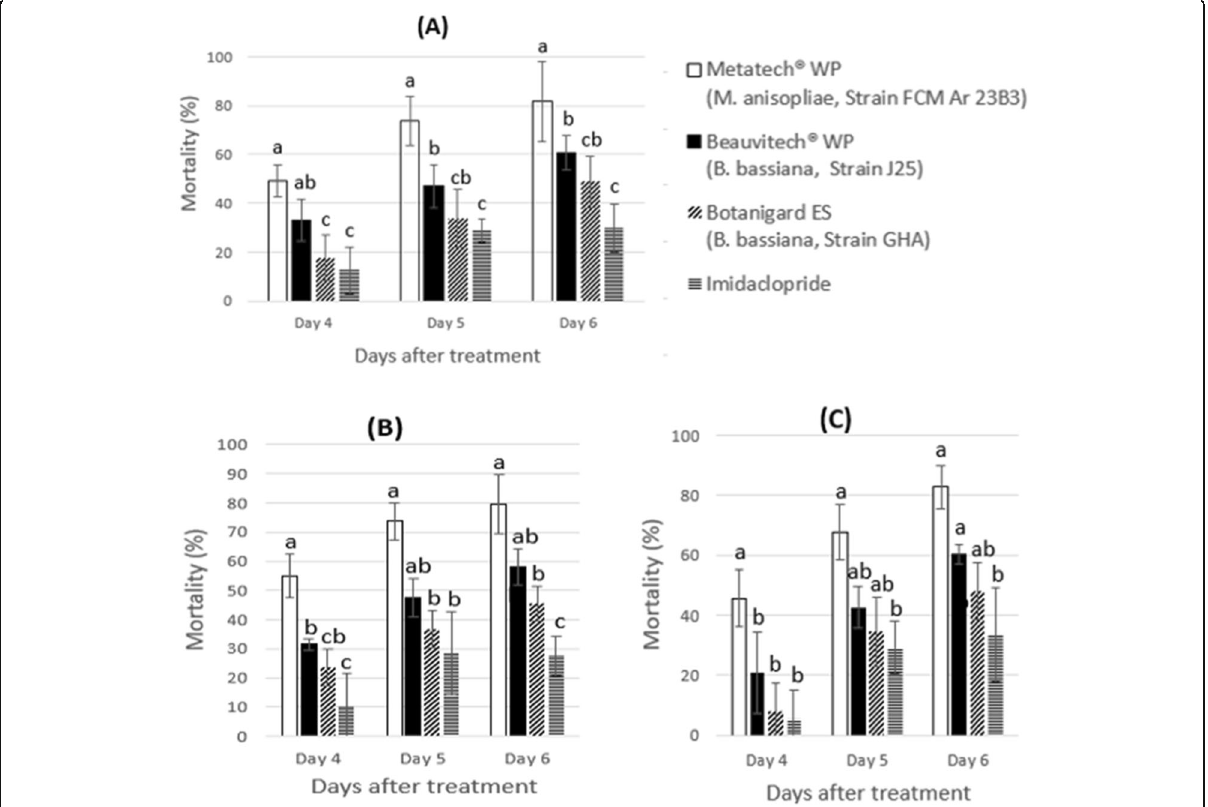
Fig. 1 Mortality (%) of Tuta absoluta larvae treated with commercial EPF formulations (10 8 spores ml − 1 ) and imidacloprid (control) in bioassays one ( a ), two ( b ), and three ( c ). Different letters above bars (mean+SD) within the same day indicate significant difference according to Tukey test ( p <0.05)